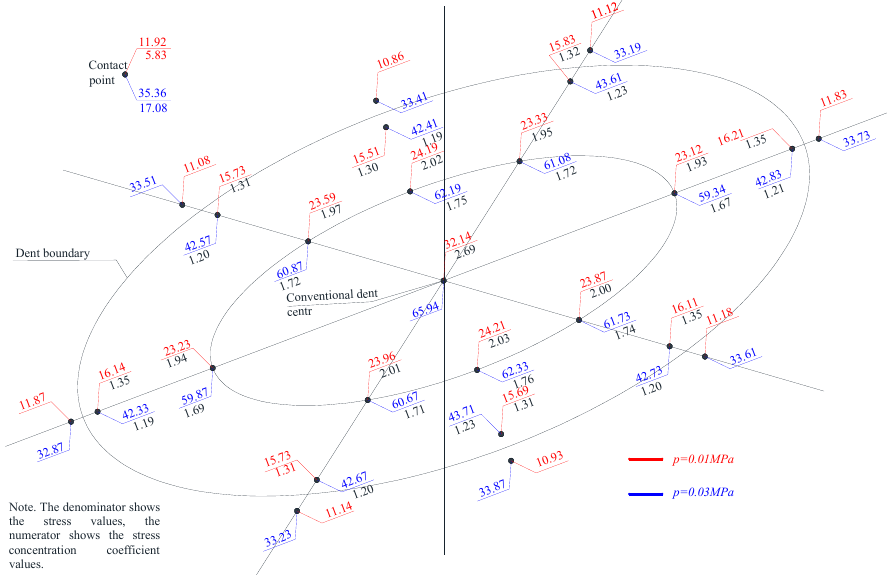
Figure 5. Distribution of hoop stresses at characteristic dent zone points in the wall of the model M1 ‐ A.